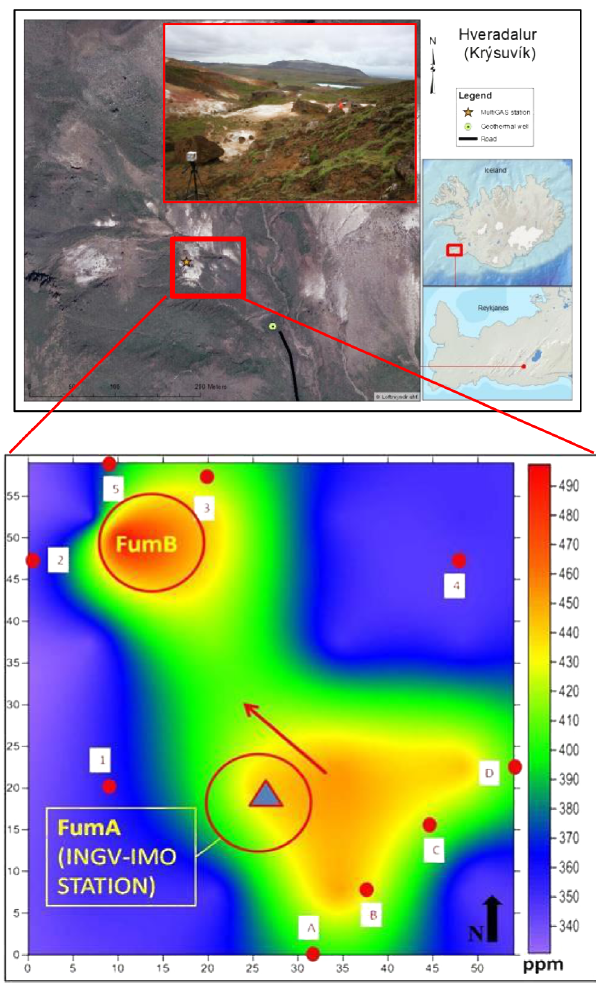
Figure 5. CO 2 Contour map of CO 2 mixing ratios (ppm), Krýsu- vík campaign of 5 July 2013. GasFinder and retro-reflectors posi- tions are shown with letters and numbers, respectively. “FumA” and “FumB”: positions of main degassing vents; blue triangle: INGV- PA/IMO station; red arrow: principal direction of plume dispersal.